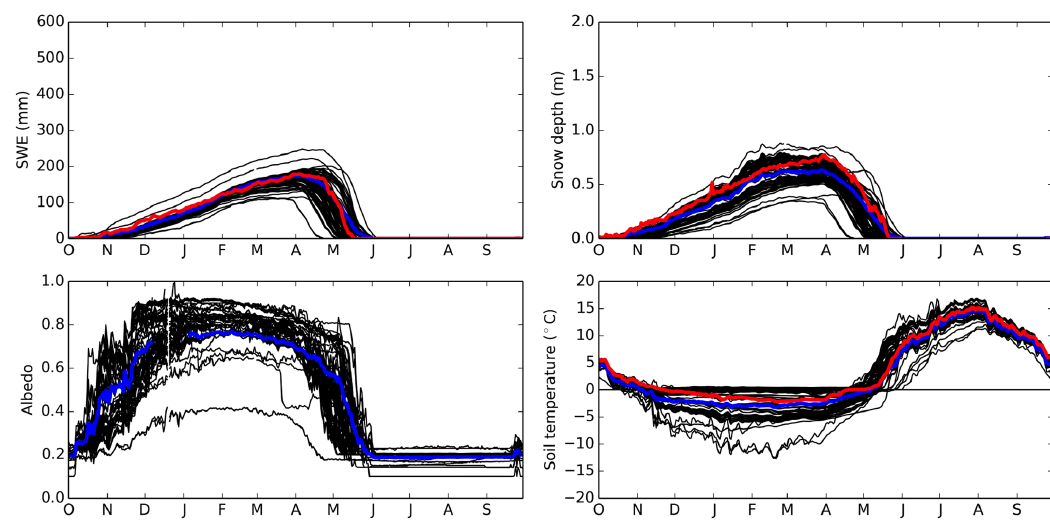
Figure 3. As Fig. 2, but for October 2007 to September 2014 at Sodankylä (albedo measurements are not available for the snow